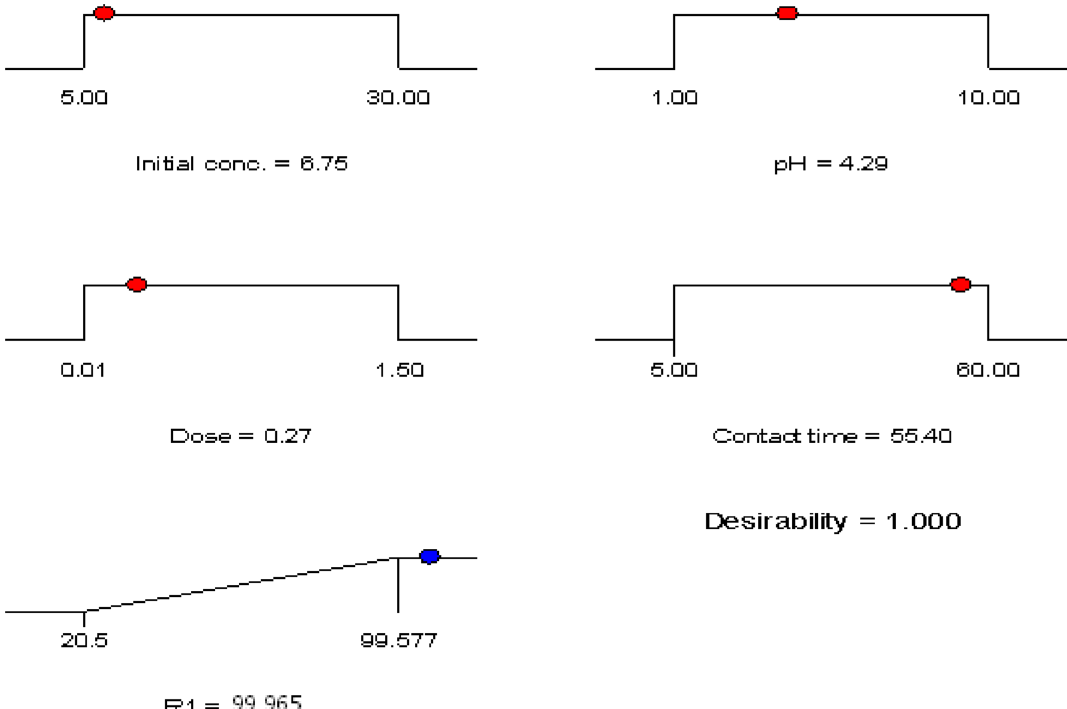
Fig. 12 Desirability for screening out the optimized parameters toward maximum Cr(VI)